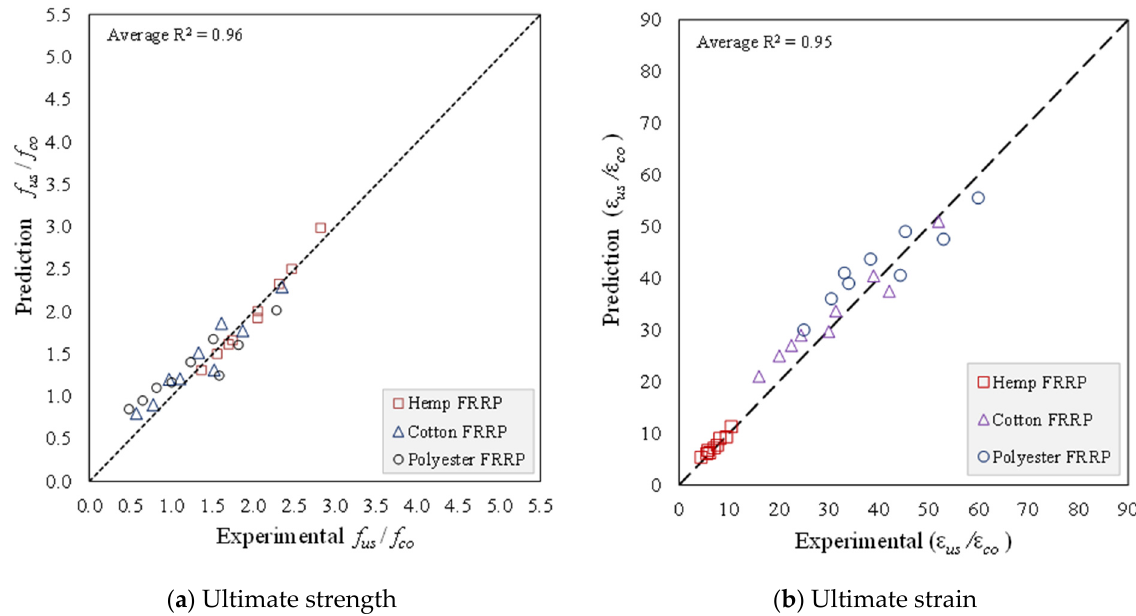
Figure 16. Verification of the proposed models.